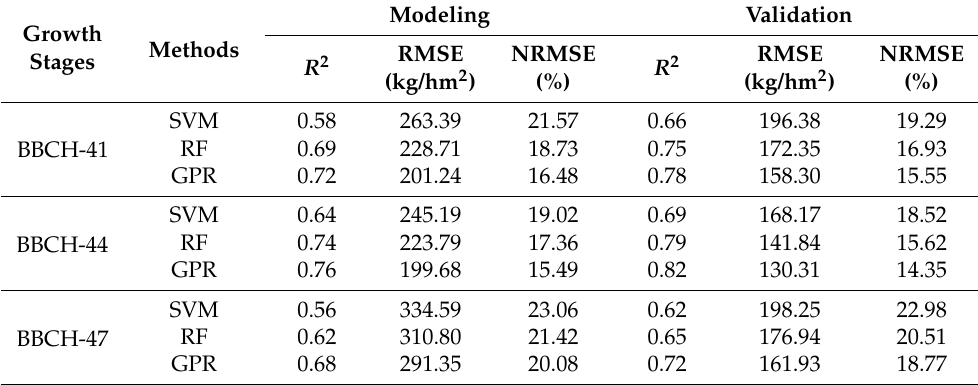
Table 9. Potato AGB estimates based on spectral information combined with CH for each growth